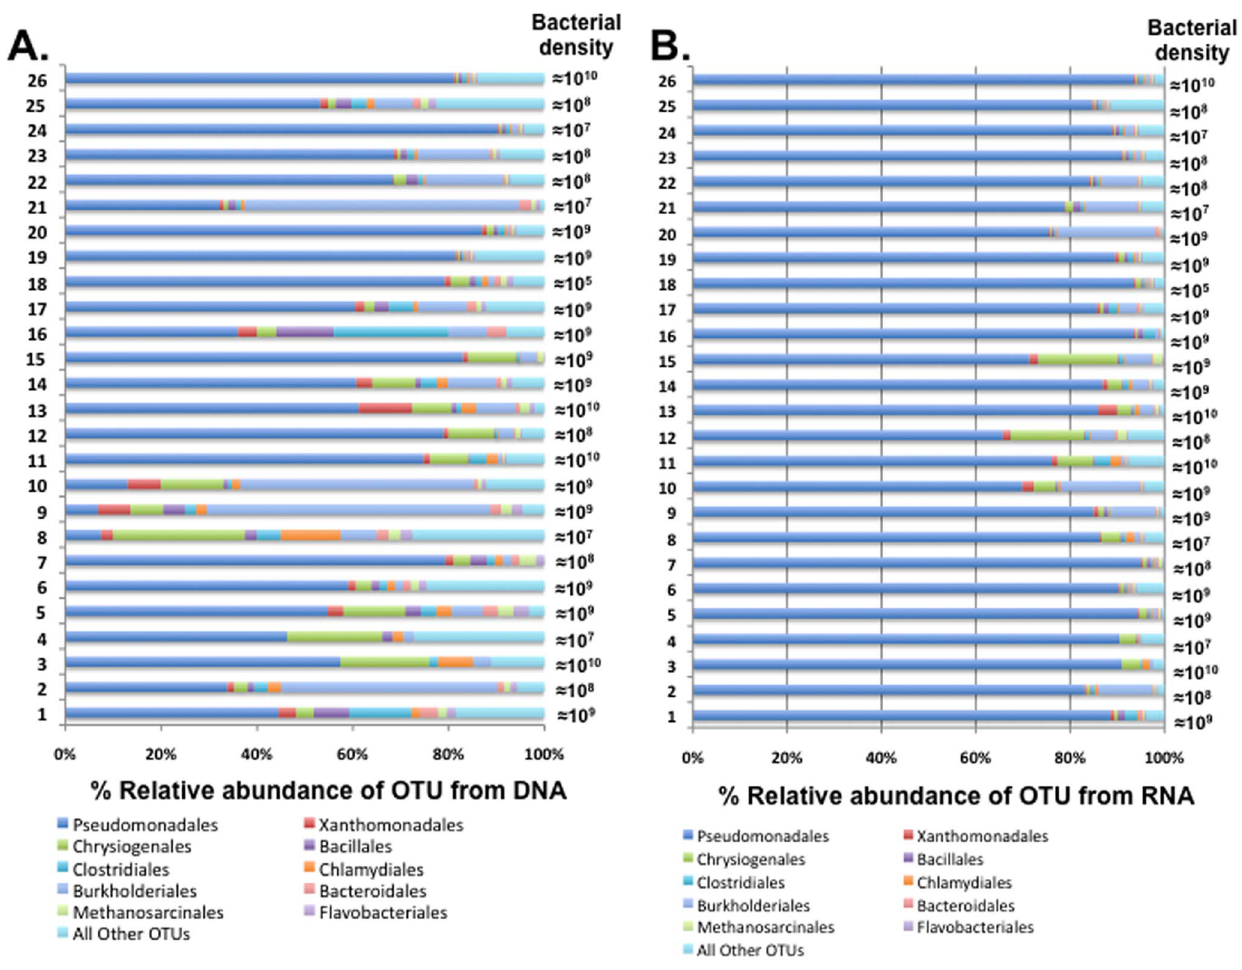
Figure 1. Relative abundances of bacterial orders identified as operational taxonomic units (OTUs) from the sequence reads generated from sputum samples of CF patients presenting with exacerbation. The coloured segments of each bar represent the proportion of reads mapping to different bacterial orders. Percentage of sequences from total DNA (A) or total transcribed RNA (B) are described. Details of clinical parameters and microbiological assessment of each of the sputum samples collected are described in Table S3. Total bacterial density in each sputum sample examined is indicated as 16S rRNA copies/ml sputum as measured by quantitative PCR.